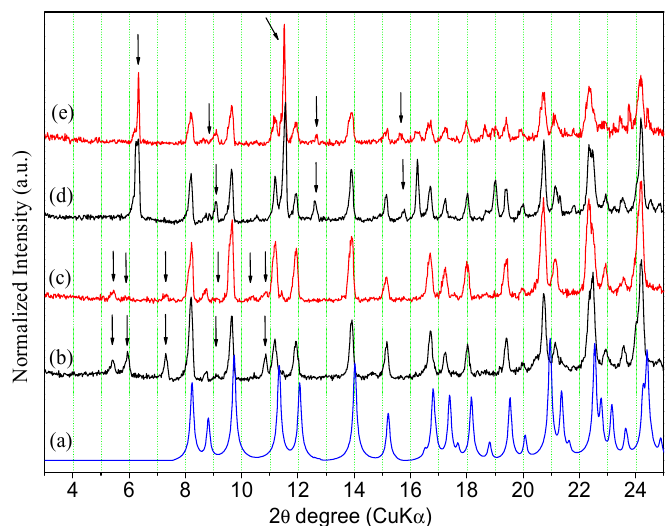
Figure 13. Calculated and experimental PXRD patterns of ORBI forms after the equilibrium solubility test: (a) ORBI hemihydrate form (calculated); (b) ORBI hemihydrate in pH 4.5 acetate buffer; (c) ORBI anhydrous in pH 4.5 acetate buffer (d) ORBI hemihydrate in pH 5.8 phosphate buffer (e) ORBI anhydrous in pH 5.8 phosphate buffer. The extra Bragg peaks are shown by arrows.